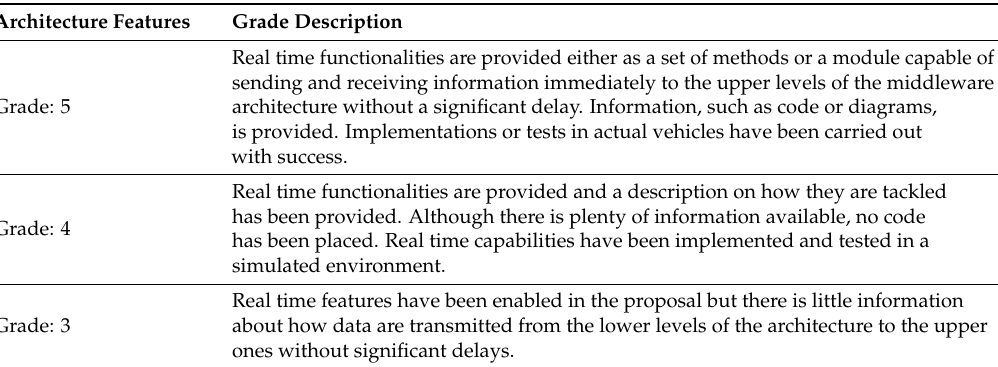
Table 9. Real time